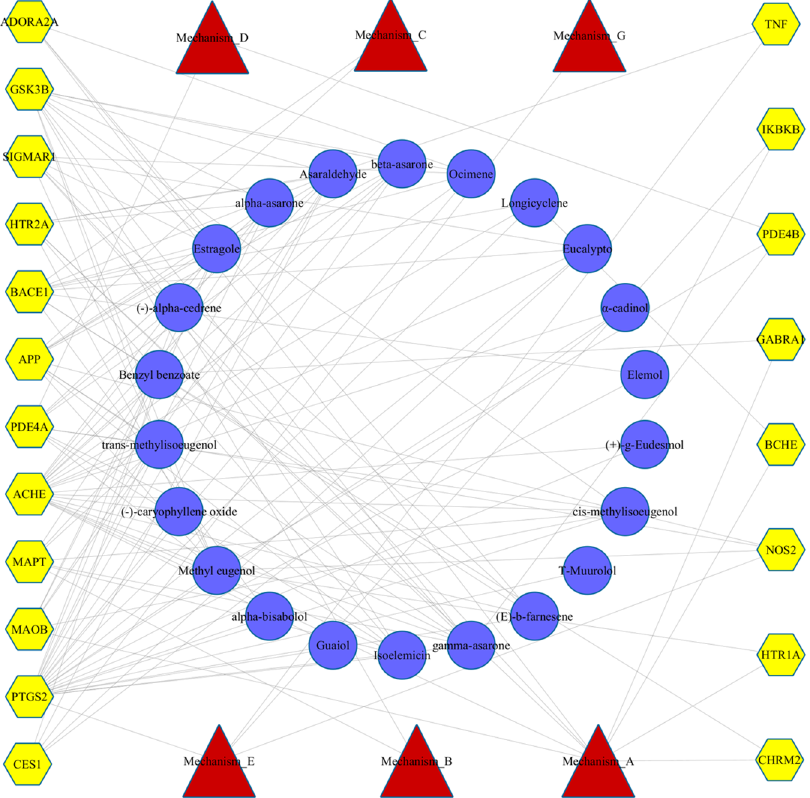
Fig 5. The compound–target–mechanism network of shichangpu based on AlzhCPI. Ellipse, hexagon and trianglerepresent drug nodes, protein nodesand mechanismnodes, respectively.